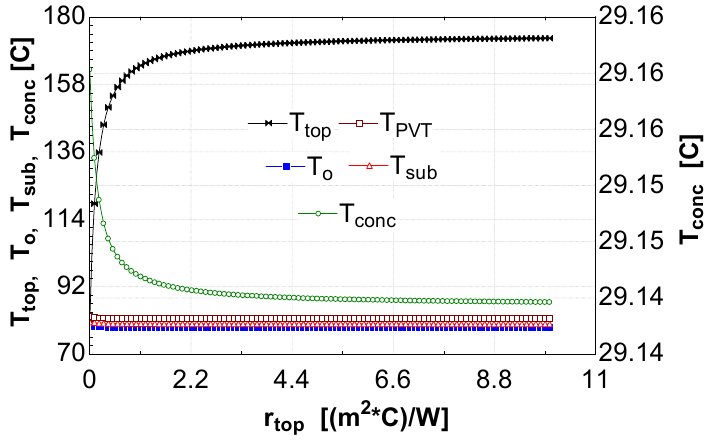
Figure 15. CPVT Temperatures vs. top thermal resistance.